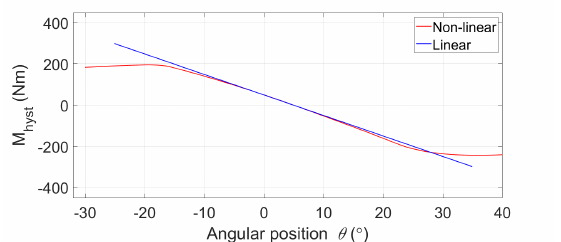
Figure 16. Hydrostatic moment calculated using a linear approach (Equation (11)) and a nonlinear approach (Equations (12) to